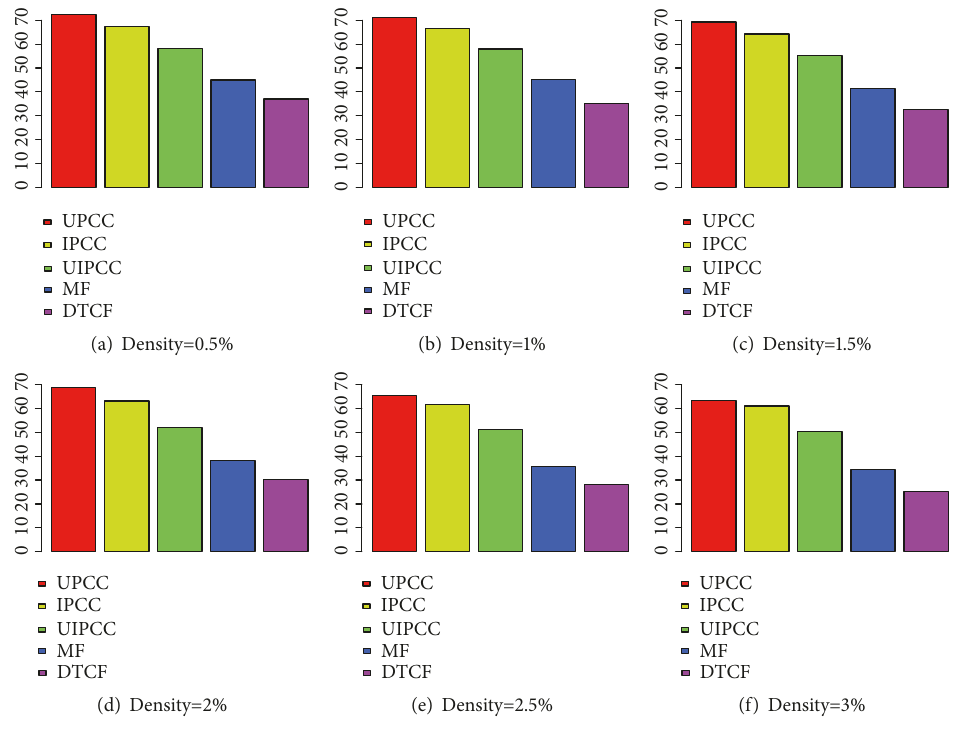
Figure 4: MAE comparison for each density.